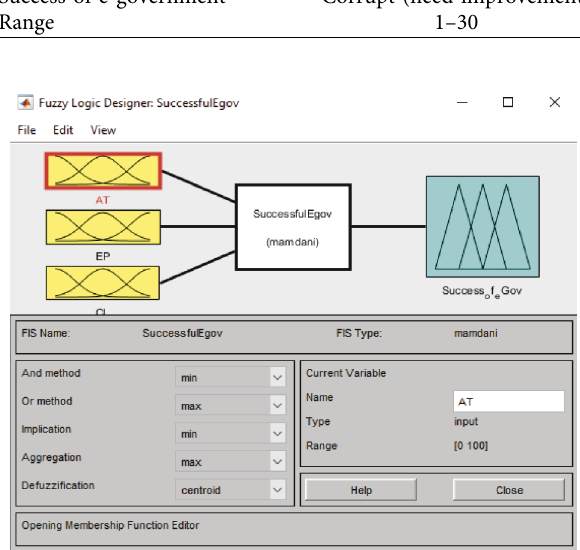
Figure 2: Design of three inputs and one output of fuzzy inference system